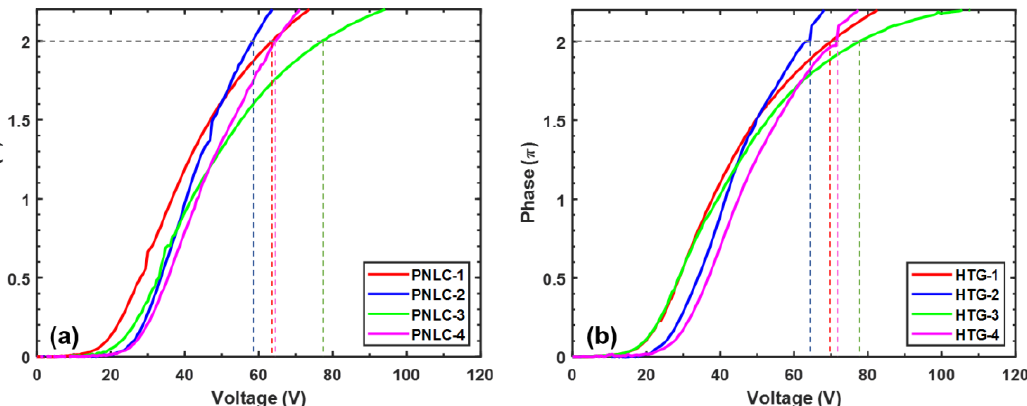
Figure 4. Voltage-dependent phase change curves of 8 transmissive PNLC samples at λ =1.06 μm: The LC host of ( a ) PNLC 1–4 is M1, and ( b ) HTG 1–4 is HTG. The operating temperature is 25 o C . The vertical dashed lines indicate the 𝑉 2𝜋 values for different samples.